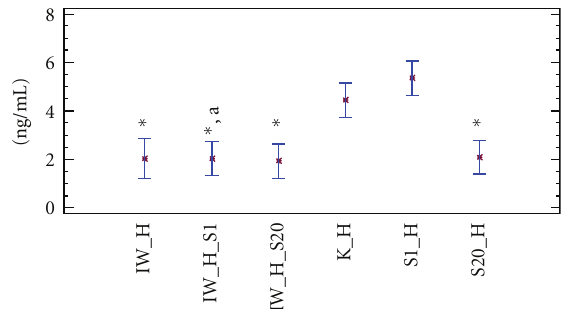
Figure 2: PAI–1 level (ng/mL) in Wistar rats fed hypercholes- terolaemic diet. K H: hypercholesterolaemic control group, IW H: hypercholesterolaemic group receiving ivabradine, S1 H: hyperc- holesterolaemic group receiving simvastatin at a dose of 1mg ×